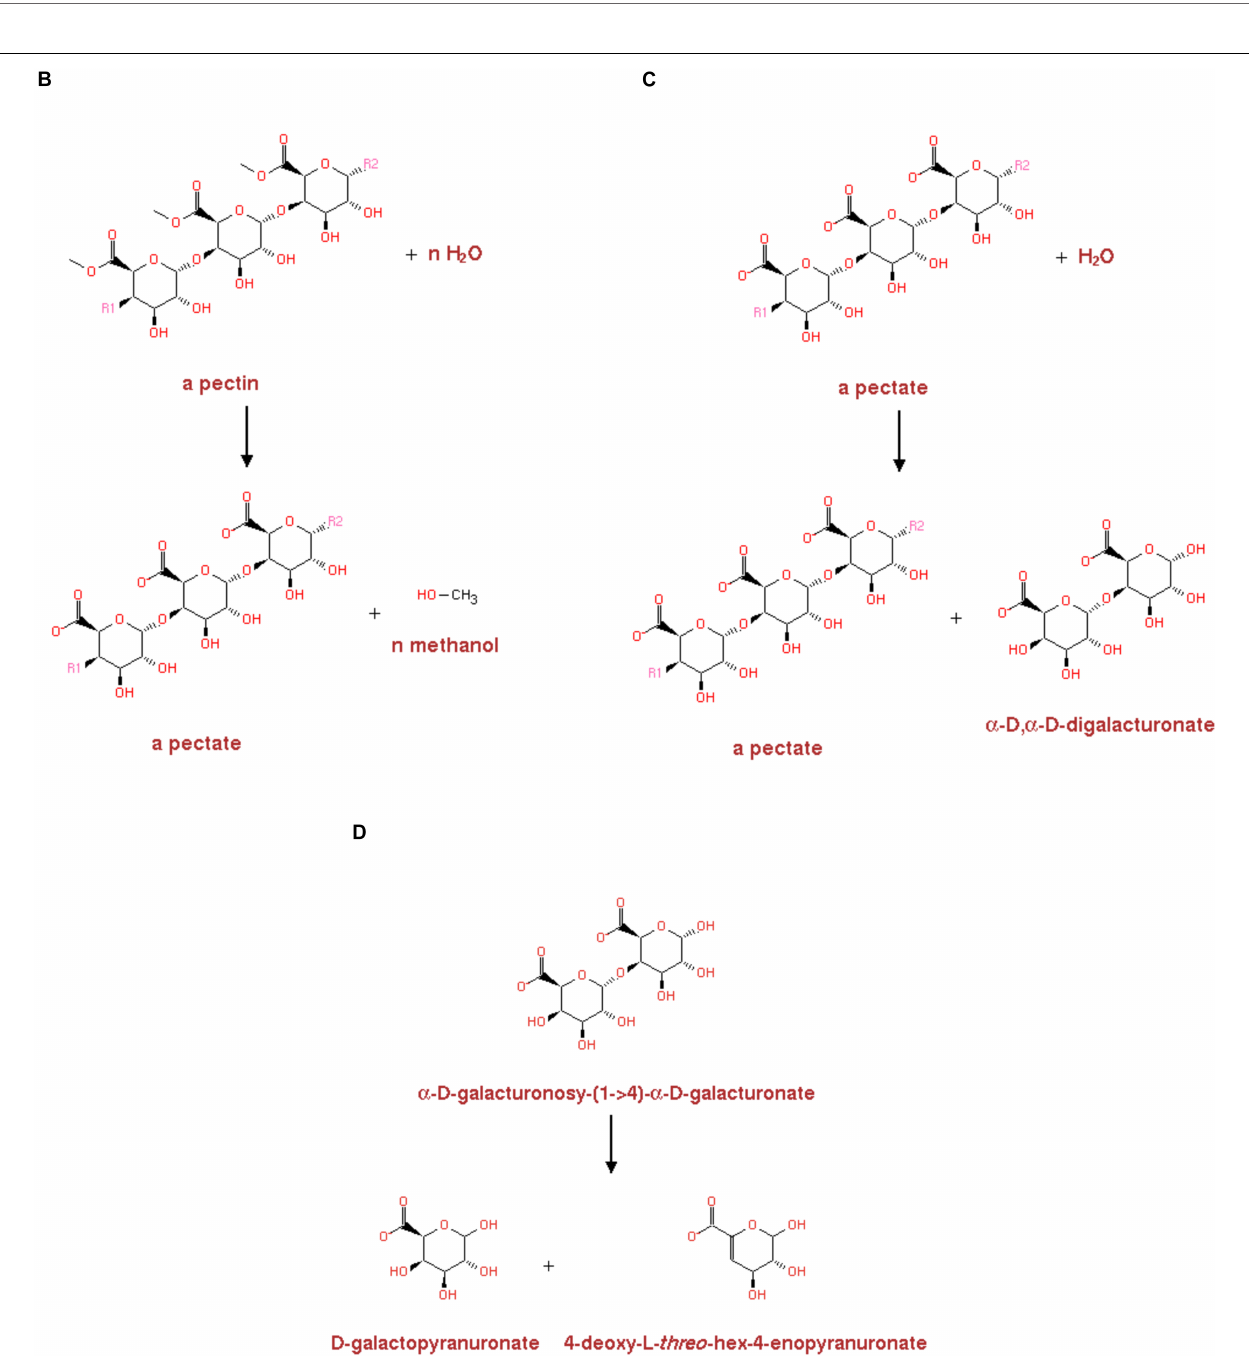
FIGURE 4 | Enzymes, genes, and products for pectin degradation in Dickeya dadantii 3937 (A) . Pectin is first acted upon by pectinesterase A (3.1.1.11) which yields a pectate and n-methanol (B) . Pectate is further degraded to α -D- α -D-digalacturonate by an exo-poly- α -D-galacturonosidase (3.2.1.82) with a pectate as a byproduct (C) . The α -D- α -D-digalacturonate is then degraded to D-galactopyranuronate 4-deoxy-L-threo-hex-4-enopyranuronate by the enzyme catalyst digalacturonate lyase (4.2.2.-) (D)